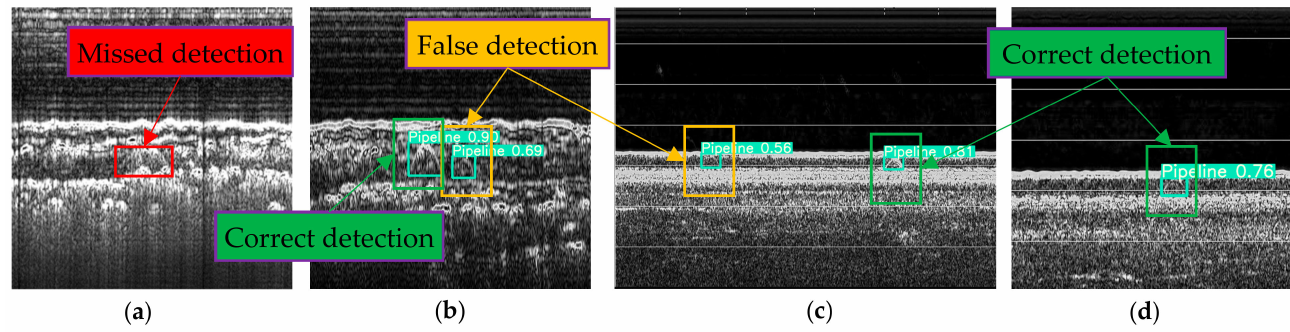
Figure 22. False detection and missed detection results. ( a ) Missed detection; ( b ) false detection; ( c ) false detection; ( d ) correct detection.